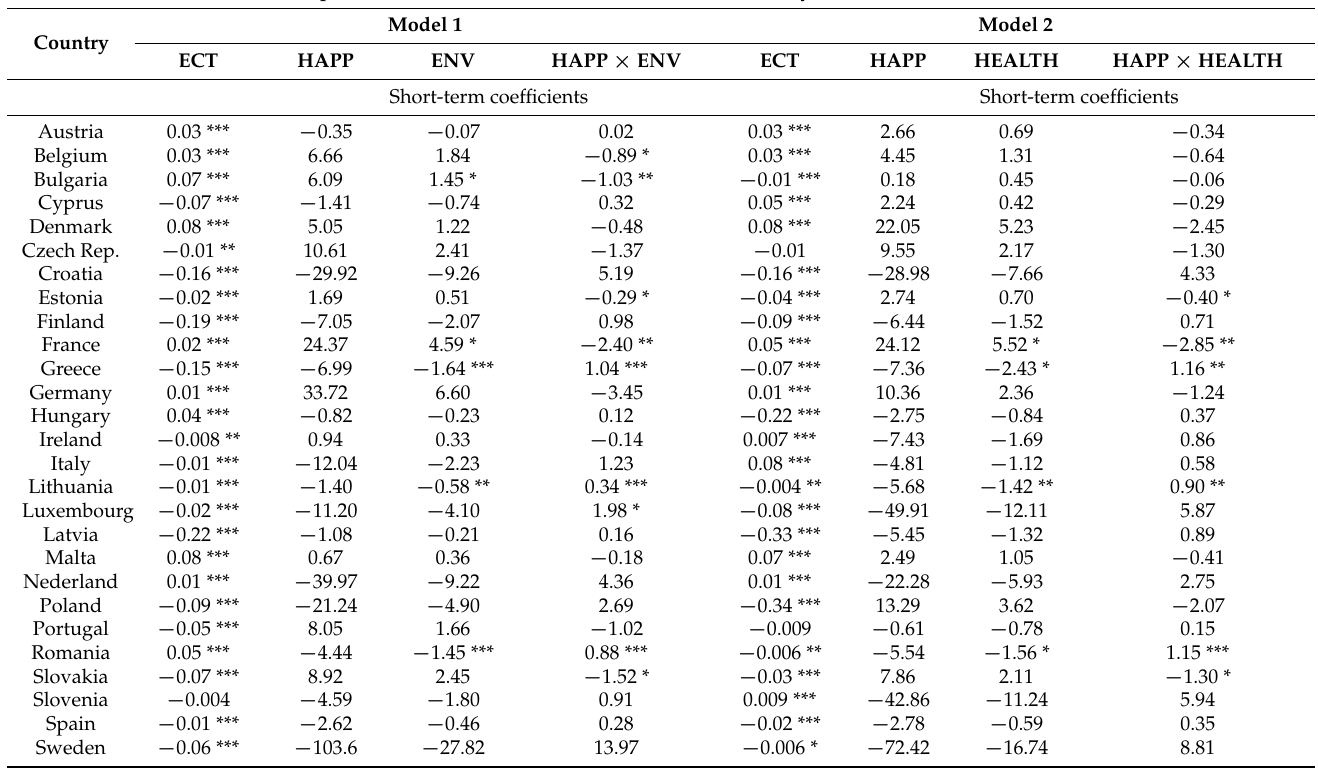
Table A1. Cross-section short-term coefficients. ARRIV—dependent